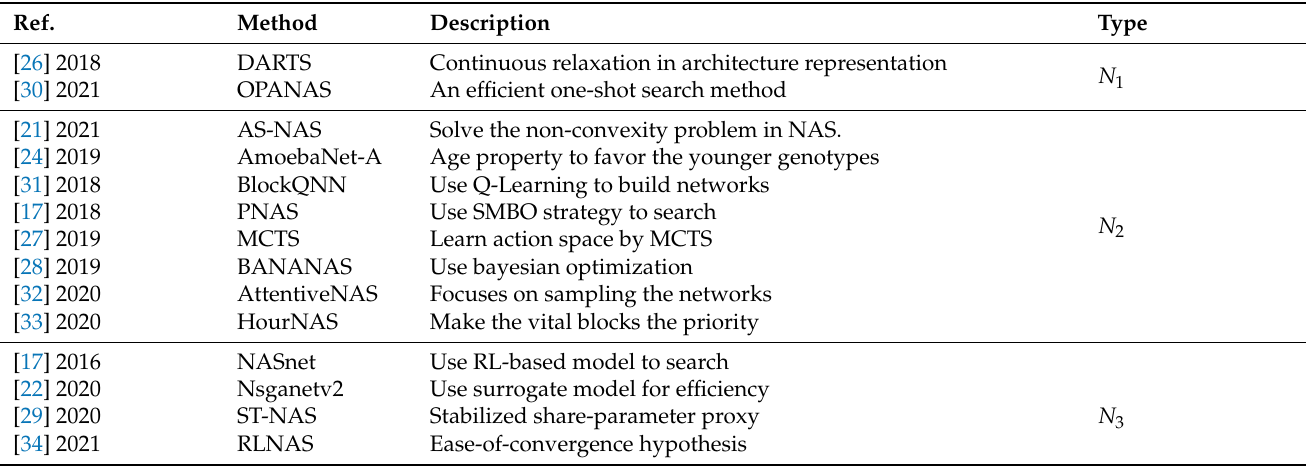
Table 1. Related work on